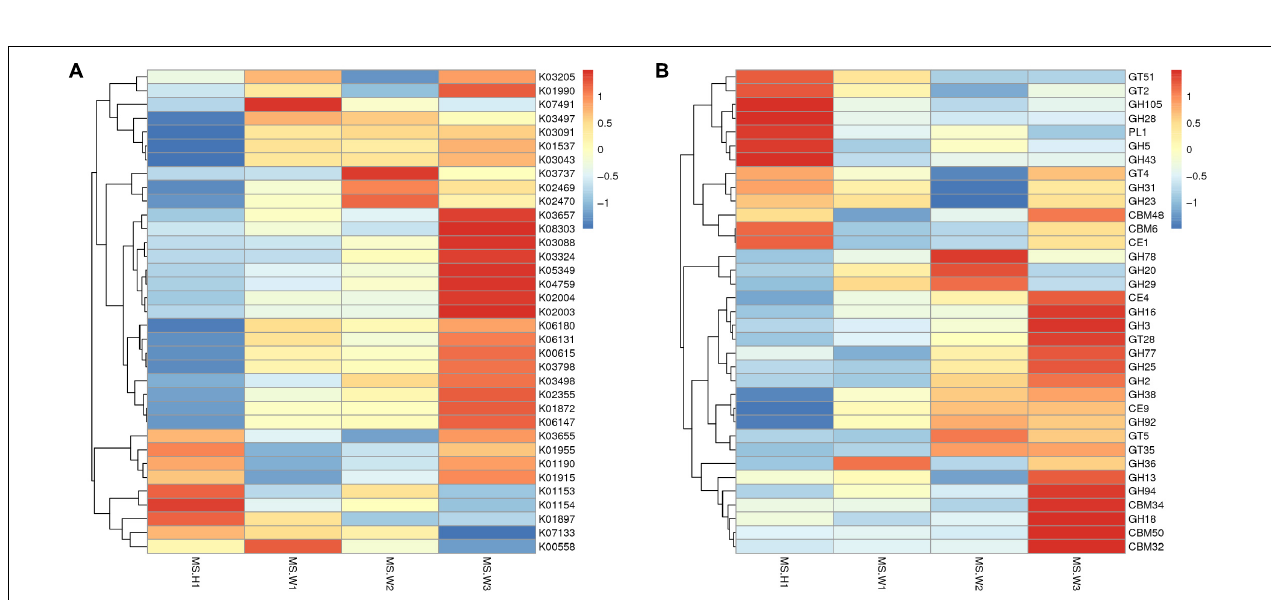
FIGURE 3 | Comparisons of gene and transcript abundance for enzymes involved in WG and CG. (A) Diagram of Co 2 /H 2 methanogenesis pathway shows enzymes involved in each biochemical reaction. (B) Relative abundance for each enzyme between WG and CG.